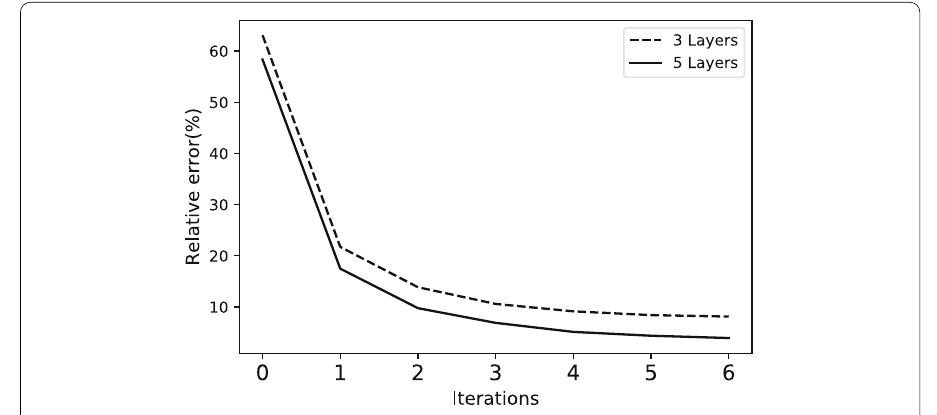
Fig. 6 Total relative error evolution for 3 and 5 layers discretizations E tot E r = , with S = S